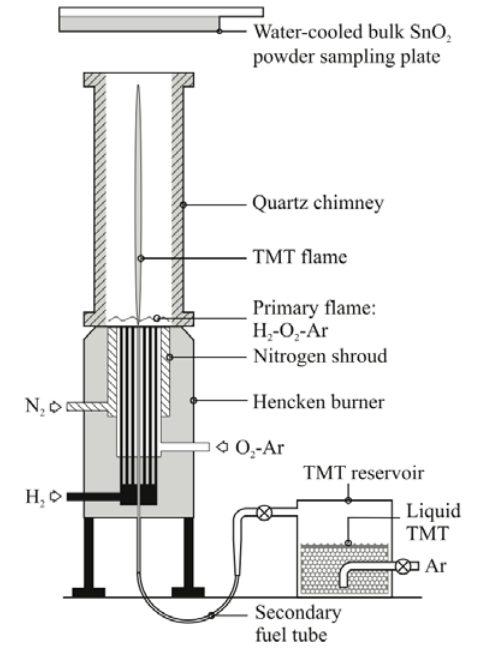
Figure 1. Schematic of the facility used to generate the combustion-synthesized SnO 2